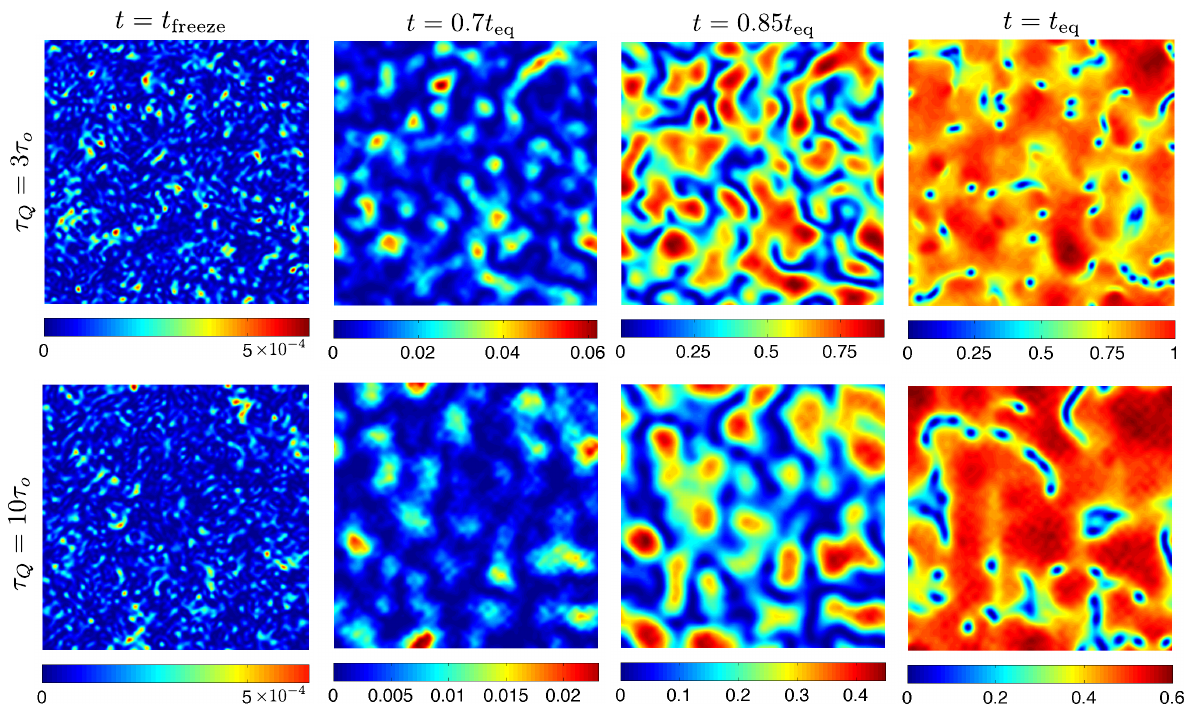
3 τ 10 τ FIG. 3. The time evolution of j ψ ð t; x Þj 2 = j ψ ð t ¼ ∞ ; x Þj 2 for τ (upper) and τ (lower) at times t ¼ t , t ¼ 0 . 7 t , Q ¼ o Q ¼ o freeze eq ≤ τ t ¼ 0 . 85 t , and t ¼ t . Similar results (not shown) are obtained for faster ( τ 0 ) quenches. The key message is that we can sensibly Q eq eq talk about defect density only after t . At t ¼ t , the order parameter is very small and dominated by fluctuations. These fluctuations eq freeze seed droplets of condensate, whose subsequent causal connection can be seen at time t ¼ 0 . 7 t . At such a time, the droplets are still eq separated by large regions where there is no condensate. Subsequently, the droplets expand and grow in amplitude and the system becomes smoother and smoother. By time t , the droplets have merged into a comparatively uniform condensate with isolated regions eq where ψ ¼ 0 . The nonuniformities — the localized blue “ dots ”— are superfluid vortices with winding number (cid:5) 1 . All dimensional quantities are expressed in units of T (B15). c